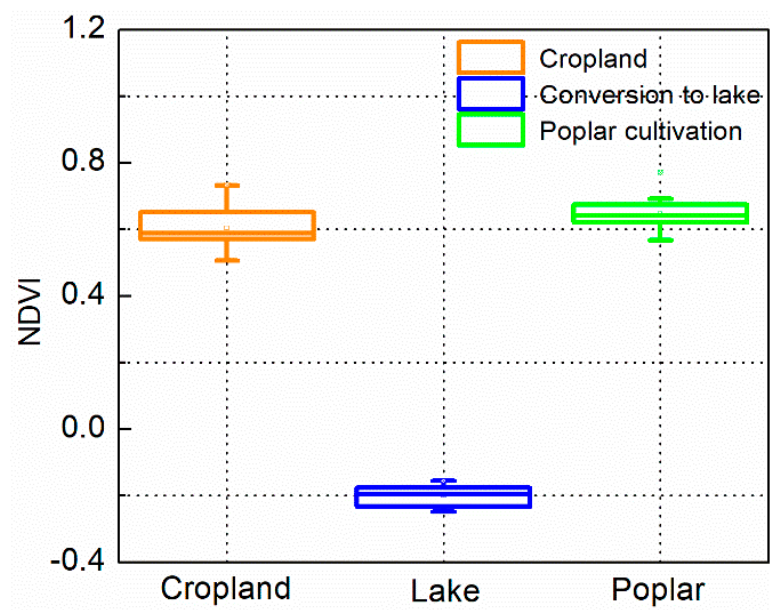
Figure 5. NDVI range of cropland, conversion to lake, and conversion to poplar cultivation in the study area.